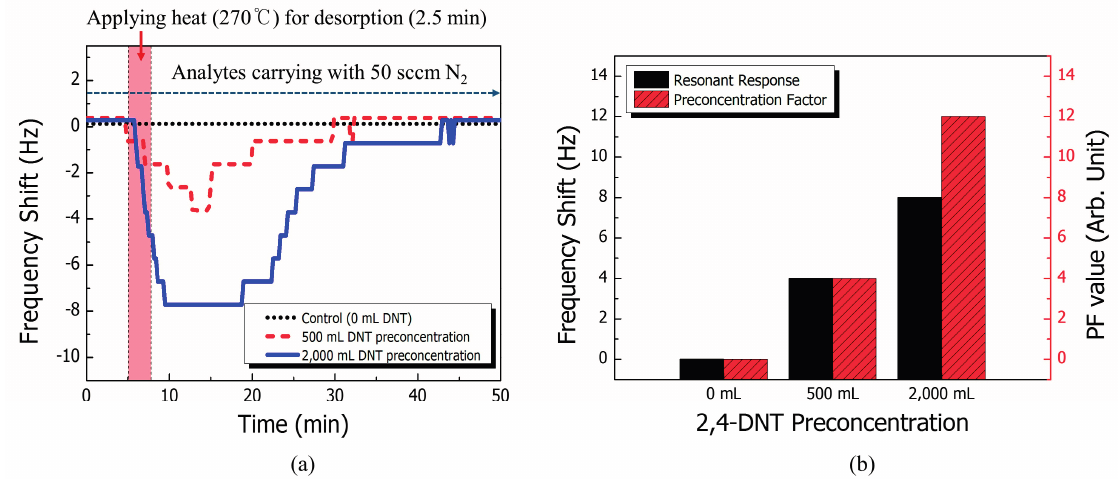
Figure 4. Performance evaluation for sample preconcentration. ( a ) Resonant response with 0, 500, and 2000 mL 2,4-DNT vapor preconcentration for the cantilever sensor with negative control. ( b ) Frequency shift and preconcentration factor for each preconcentration